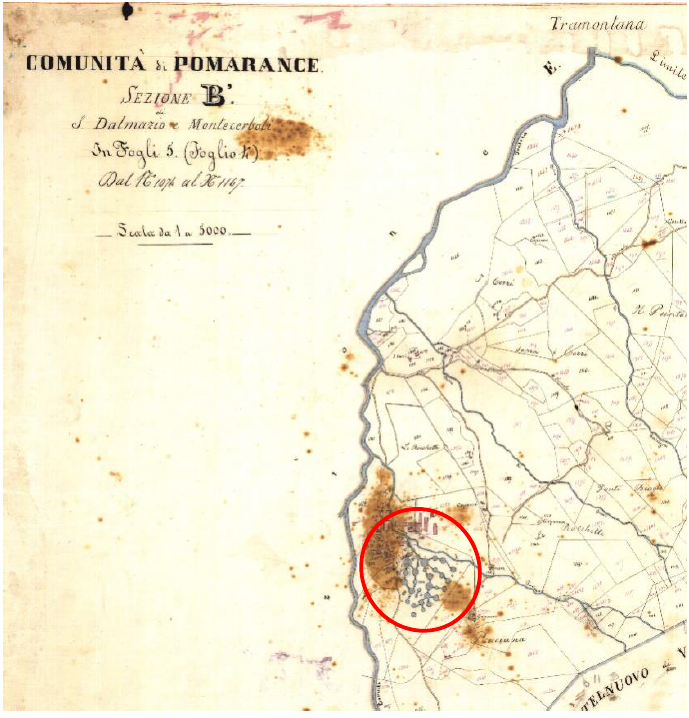
Figure 4. The ancient ‘lagoni’ in Larderello (outlined in circle) from a topographic map dated before 1827.